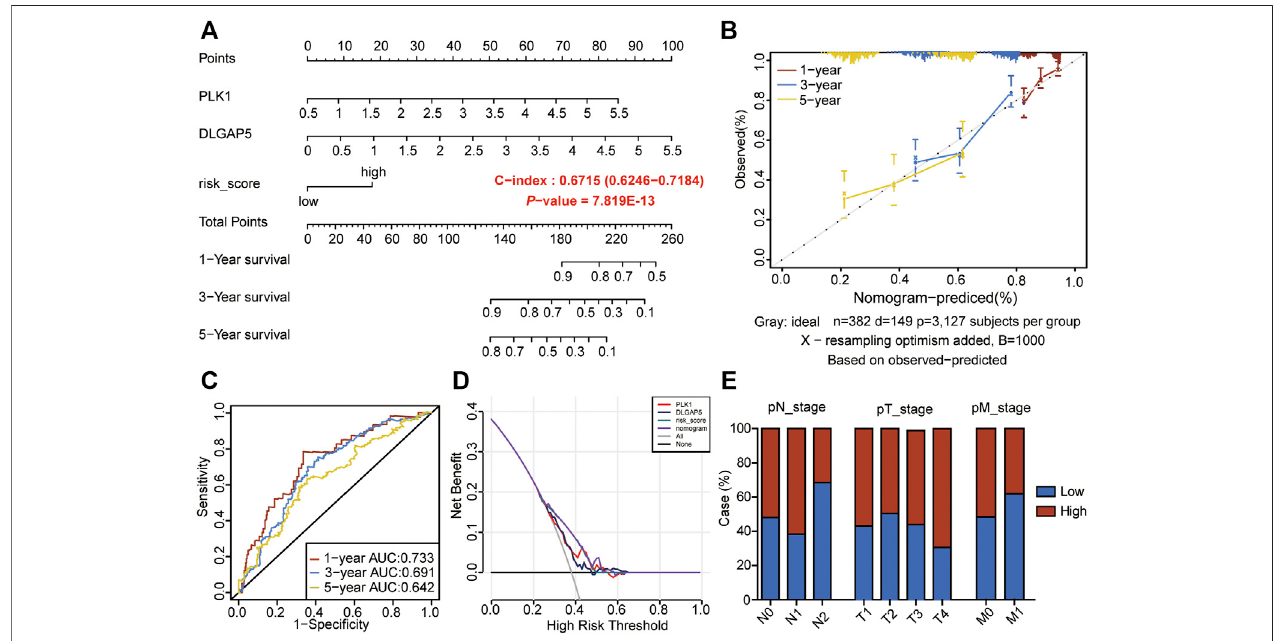
FIGURE 3 | Construction of nomogram model by the 9-gene prognostic signature. (A) The nomogram to predict the prognosis of LUAD-patients. (B) The calibration analysis of the nomogram predicted a probability of 1-, 3-, and 5-years survival. (C) ROC analyses of the nomogram model for 1-, 3-, and 5-years. (D) DCA result of the prognostic model. (E) Risk groups in relation to a clinical index.